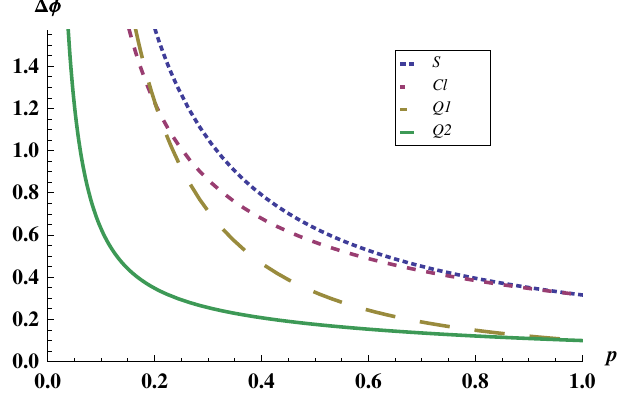
FIG. 2. Phase uncertainty ( (cid:3) (cid:5) ) for N ¼ 10 . The lower bound on the phase uncertainty is given by the quantum Fisher infor- mation as a function of p (see Table I). Q 2 is by far the most optimal strategy for all values of p , while Cl is better than Q 1 for small values of p